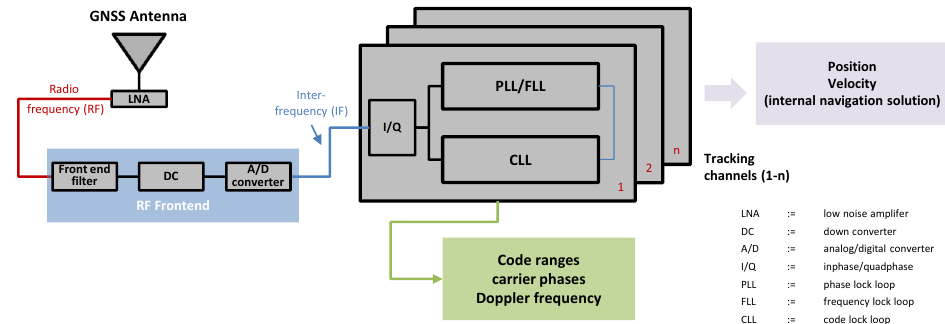
Figure 3. GNSS signal processing chain inside a receiver from the antenna to the tracking